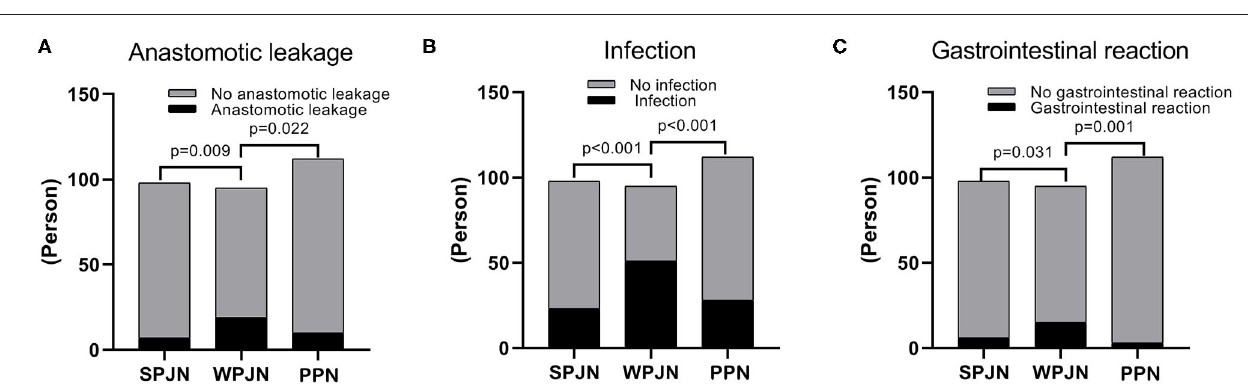
FIGURE 5 | Complications. The incidence rate of anastomotic leakage in the SPJN group was significantly lower than that in the WPJN group, and it was also markedly lower in the PPN group compared to that in the WPJN group (A–C) .